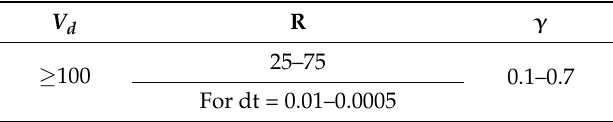
Table 1. Recommended initial values for V d , R , and γ